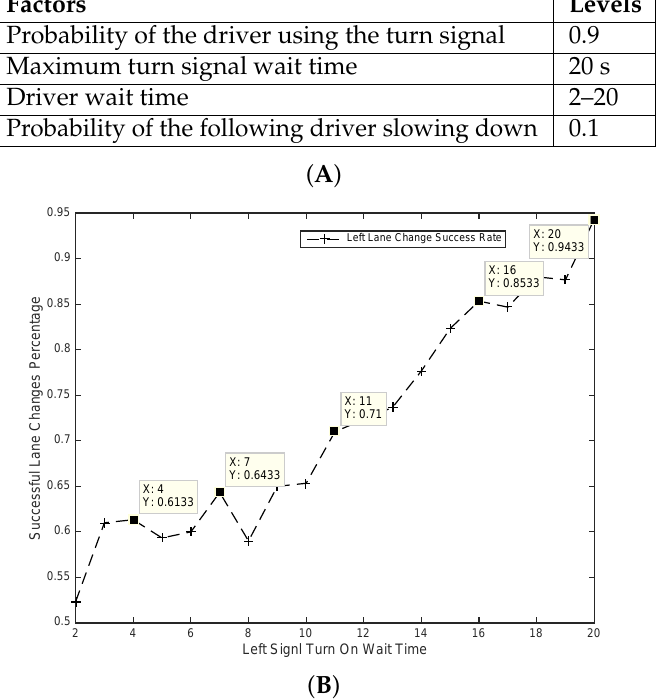
Figure 4. ( A ) the parameters for simulating the impact of the turn signal duration; ( B ) the rate of successful lane change function of the driver wait